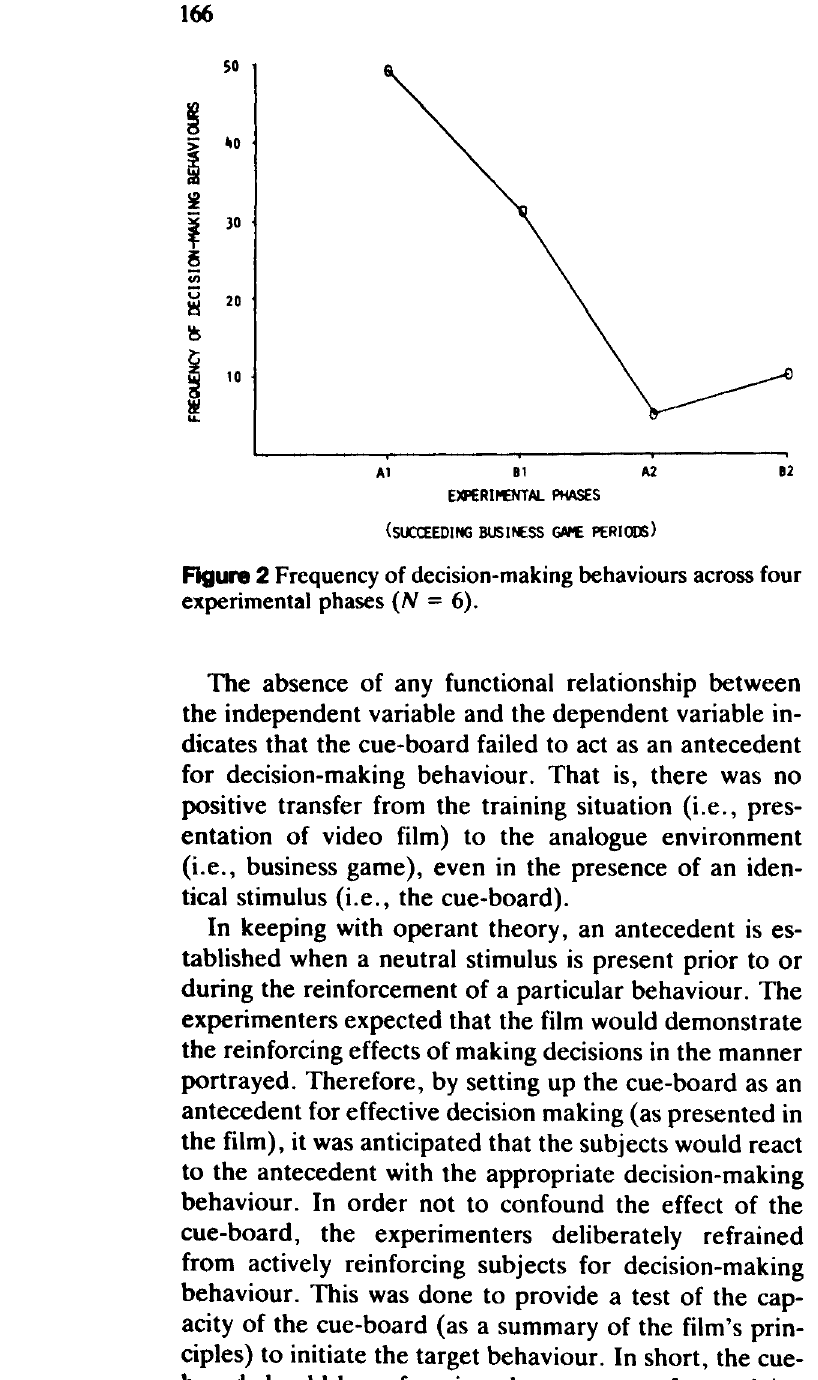
Figure 2 Frequency of decision-making behaviours across four experimental phases (N =